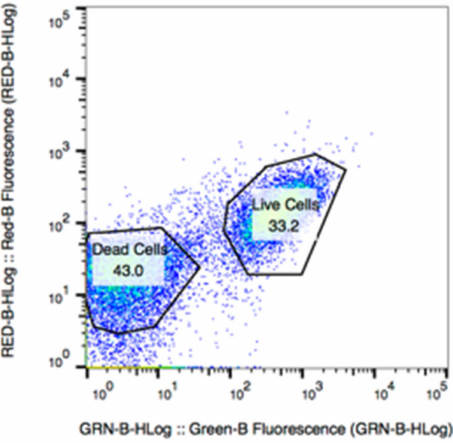
Figure 2. Raw flow cytometry data collected from the incubation of 0.5 wt % of tungsten oxide with Staphylococcus aureus cells for 24 h at 37 ◦ C and 150 rpm.